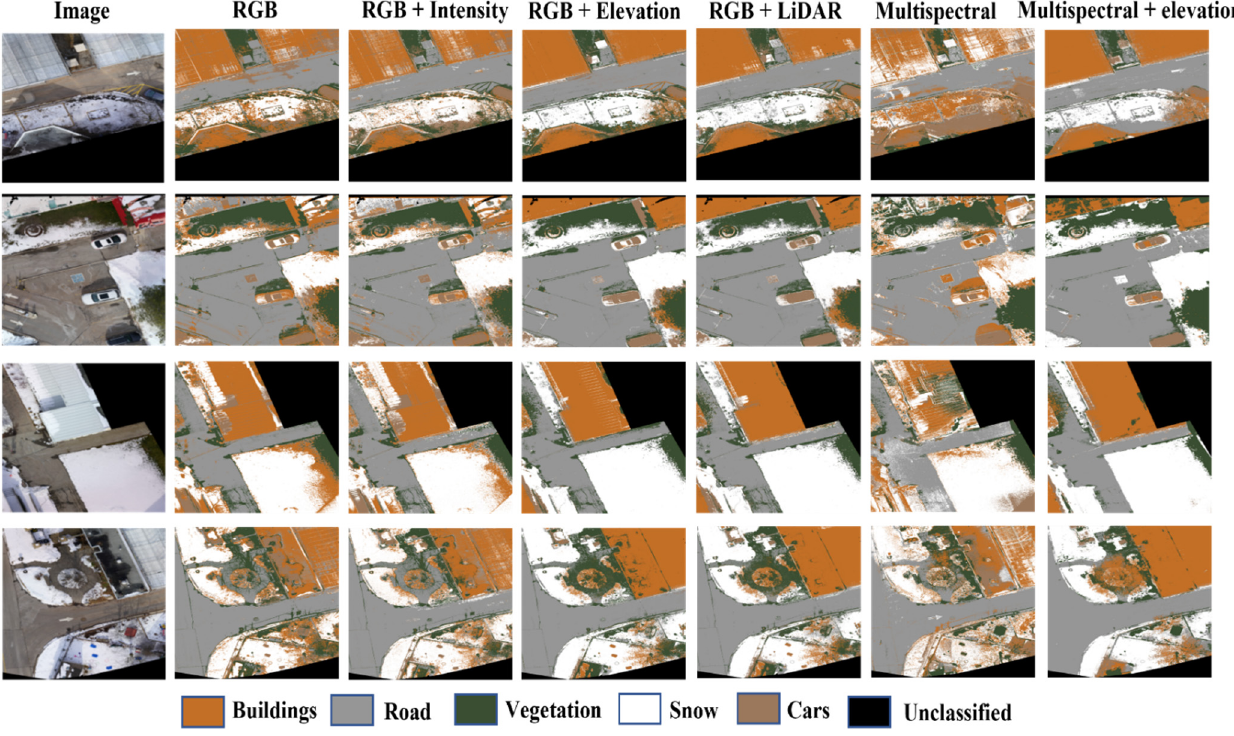
Figure 20. Classification results using the SVM technique. Table 2. Classification results of the six combinations using the SVM technique.